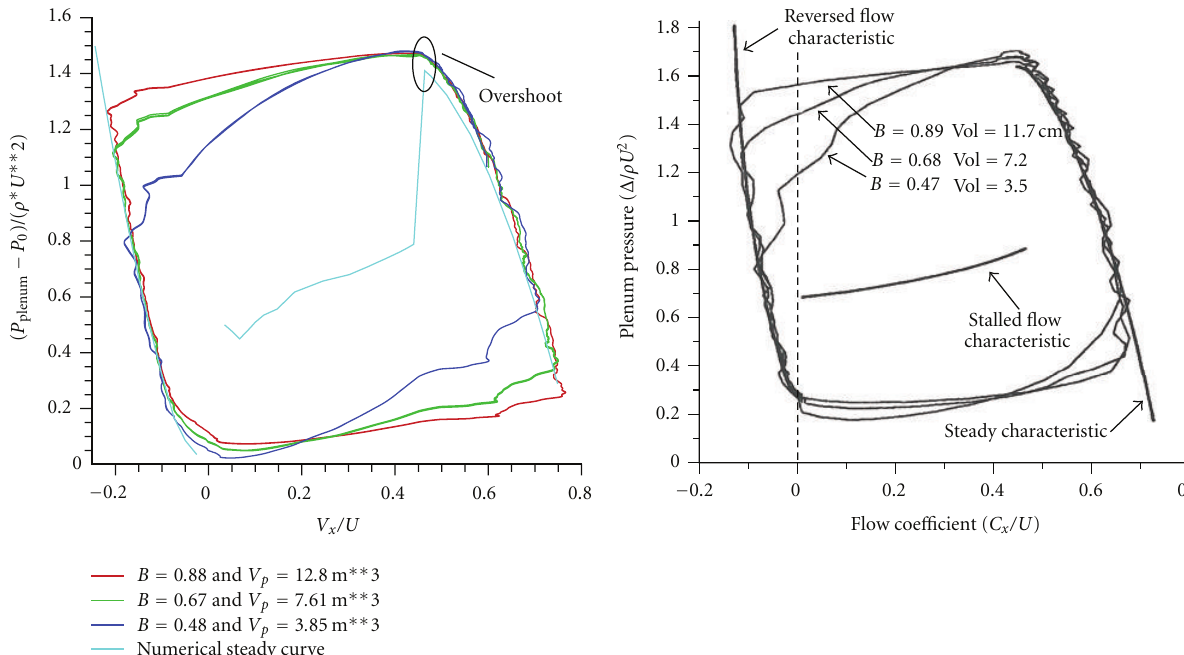
Figure 6: Numerical and experimental performance characteristics during surge